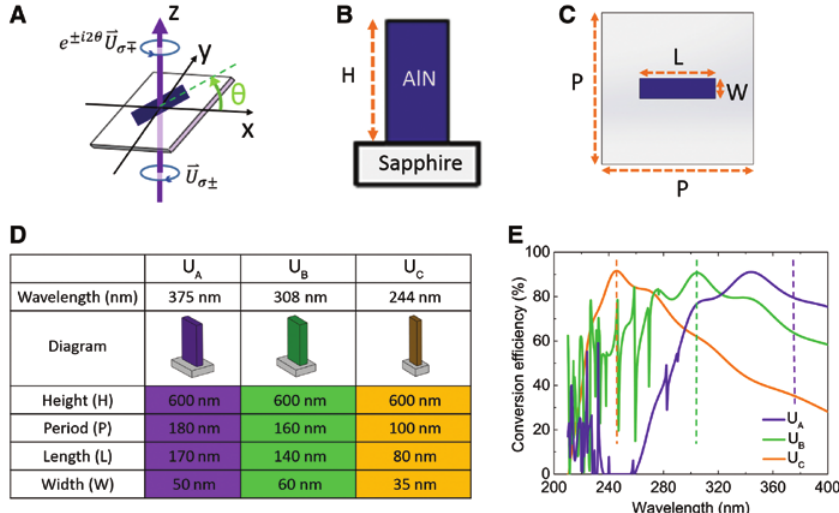
Figure 2: The designed metalens is made up of high-aspect-ratio AIN nanorods. (A) Transmission schematic diagram of circularly polarized light through an AlN nanorod with an orientation angle of θ , with incident (cid:31) (cid:31) , U transmitted light with opposite circularly polarization, , U circularly polarized light, which is imprinted with a geometrical phase σ ± σ ∓ of e ± i2 θ . The left- and right-handed circularly polarized lights are labeled as s ± , respectively. Cross section (B) and top view (C) of the AlN nanorod on the sapphire substrate, with height H, width W, length L and period of the unit cell, P. (D) Geometric dimensions and structure diagrams of three AlN nanorods, marked as UA, UB and UC, respectively. (E) Conversion efficiency between transmitted RCP light and incident LCP light of three AlN structures UA, UB and